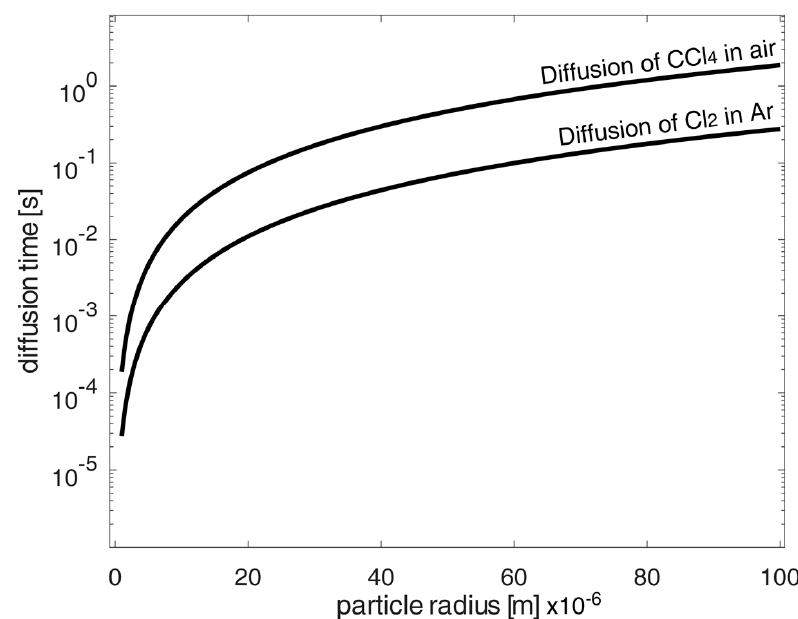
Figure 3. Exemplary calculated diffusion time form the shrinking core model of spherical oxidized NdFeB magnetic material particle at high porosities p to 95 mole% under chlorination conversion rate of 100%.